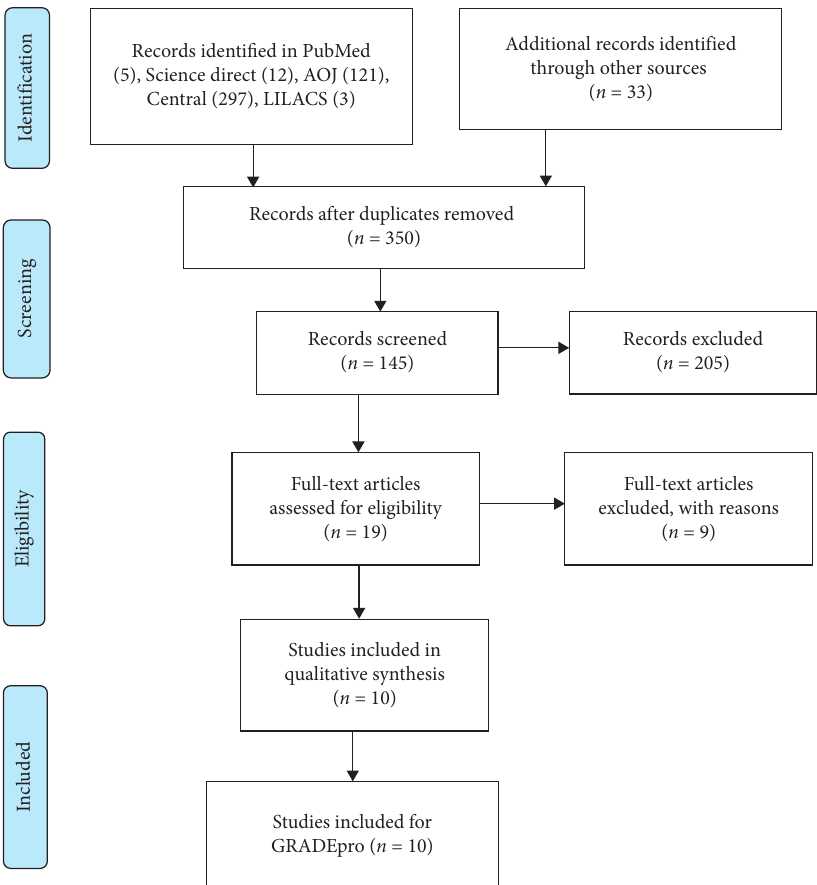
Figure 1: PRSIMA flow